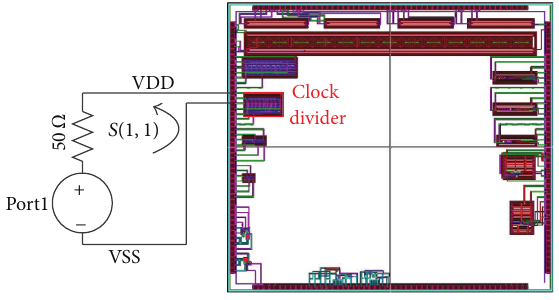
Figure 5: X-ray picture of the chip